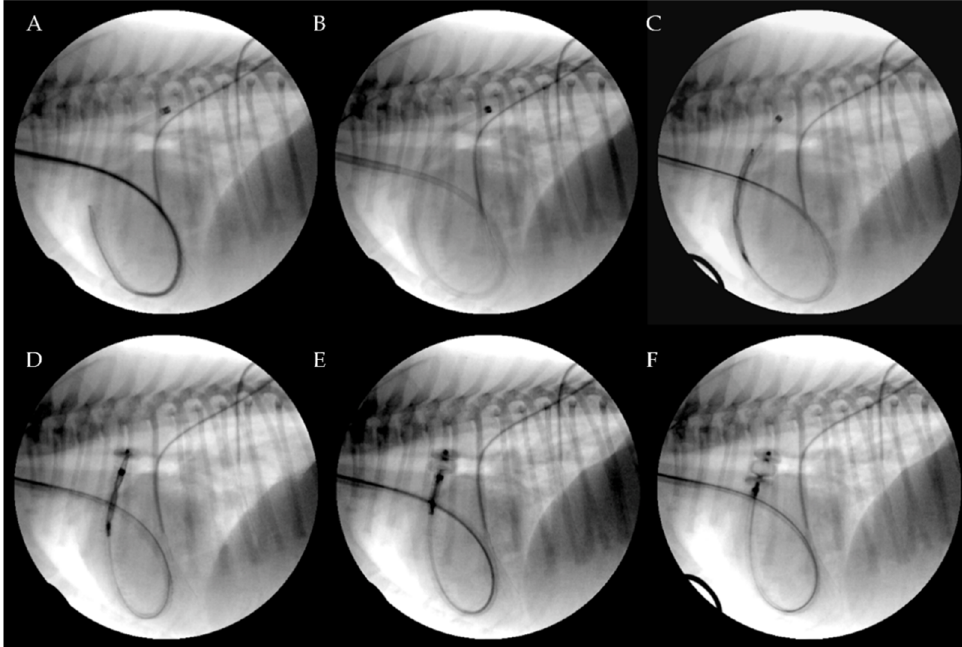
Figure 3. Transjugular patent ductus arteriosus occlusion using the Amplatzer Vascular Plug II. The PDA was crossed retrograde using a straight soft guidewire advanced into the descending aorta through the right ventricle and the pulmonary artery on a 5 Fr multipurpose catheter. The soft guidewire was replaced by a standard Cook Rosen PTFE curved guidewire used to position the tip of the Flexor Balkin guiding sheath into the aorta and was then removed ( A ). The Flexor Balkin guiding sheath is in correct position ( B ). The device was introduced into the Balkin guiding sheath ( C ). The Amplatzer Vascular Plug II was advanced ( C ), partially ( D ) and fully extruded ( E ) and occluding the PDA ( F